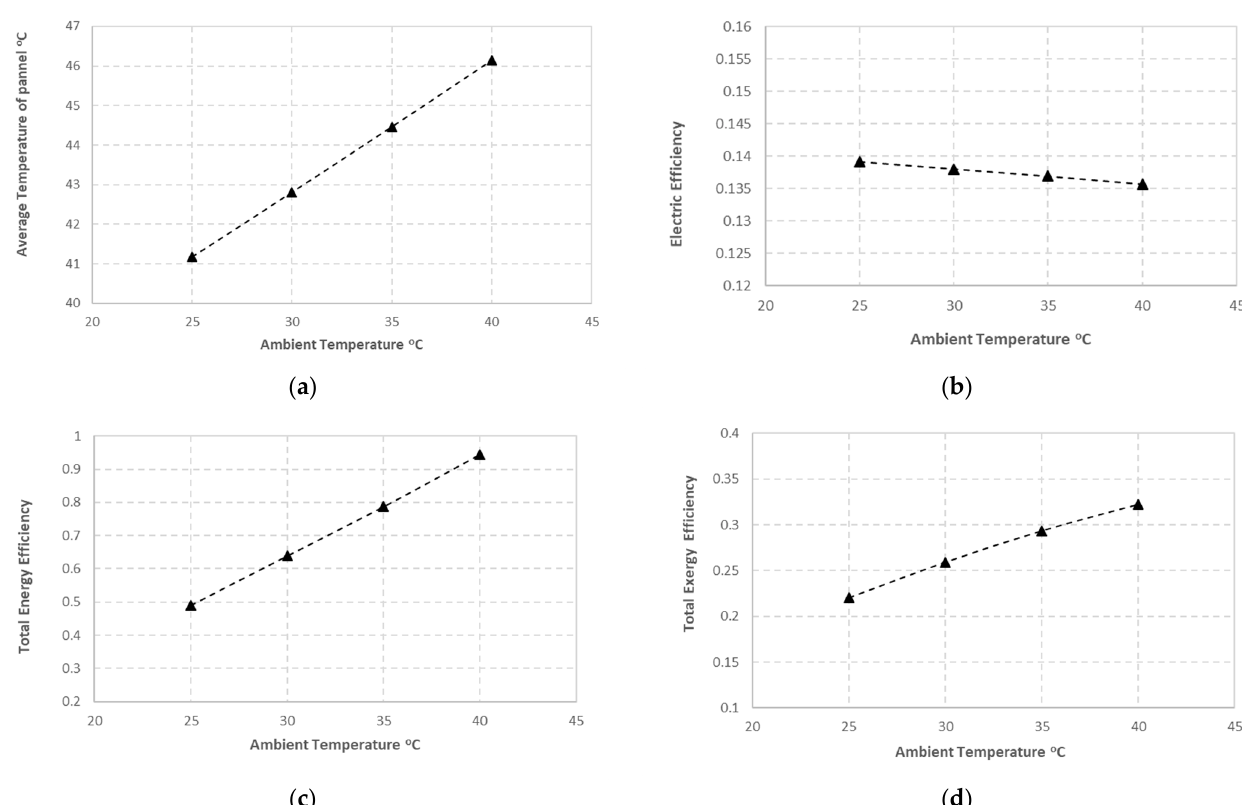
Figure 21. The influence of ambient temperature on ( a ) average temperature of panel ( b ) electrical energy efficiency ( c ) total energy efficiency ( d ) total exergy